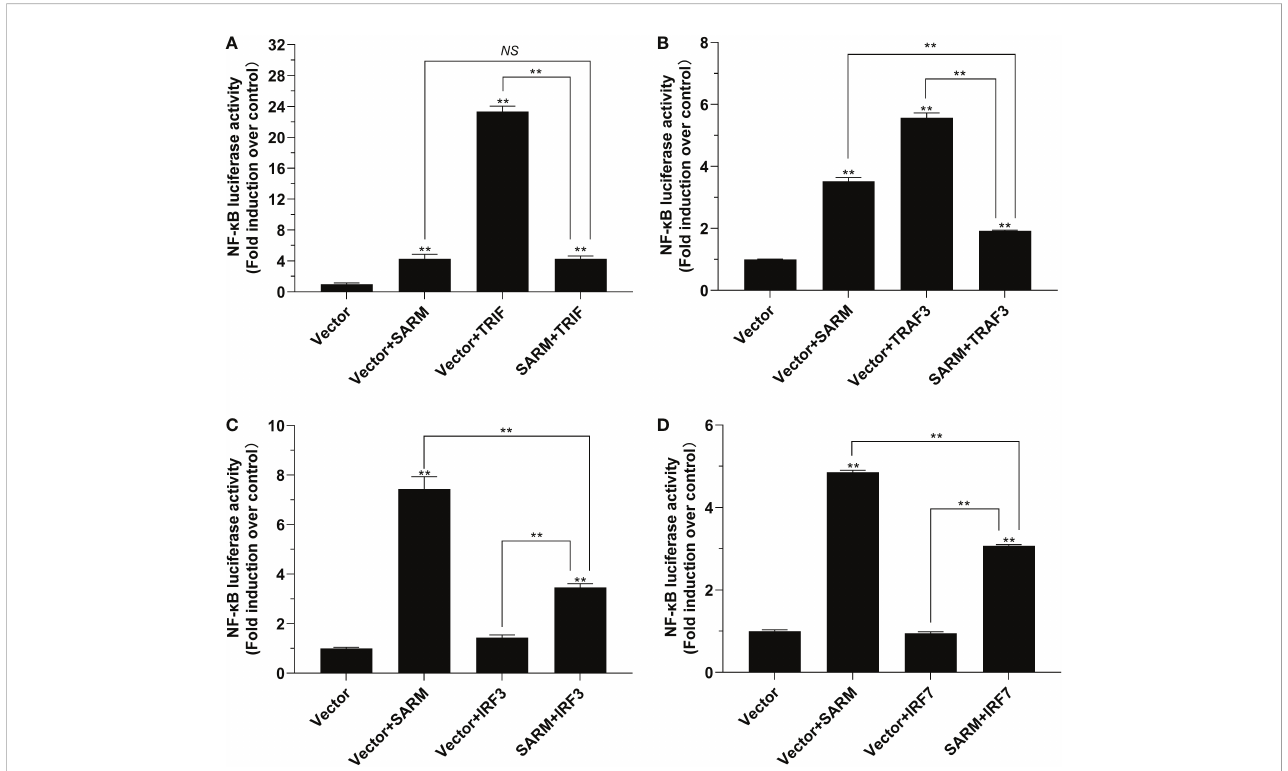
FIGURE 6 The role of Lc- SARM in the regulation of NF- k B signaling. The associations of Lc- SARM with Lc- TRIF (A) , Lc- TRAF3 (B) , Lc- IRF3 (C) , and Lc- IRF7 (D) in the NF- k B promoter activation were analyzed by luciferase reporter assays. HEK 293T cells seeded in 24-well plates (1 × 10 5 cells/well) were co- transfected with 100 ng of pNF- k B-luc and 10 ng of pRL-TK together with 100 ng of pcDNA3.1-SARM, pcDNA3.1-TRIF, pcDNA3.1-TRAF3, pcDNA3.1- IRF3, and pcDNA3.1-IRF7 alone or in a combination of two. For each transfection, the amounts of transfected plasmids were balanced with the pcDNA3.1 empty vector. At 24 hpt, the cells were collected and lysed for the measurement of luciferase activities. All data are shown as mean of three independent experiments, with bars representing the SE. * P < 0.05; ** P < 0.01; NS, not signi fi